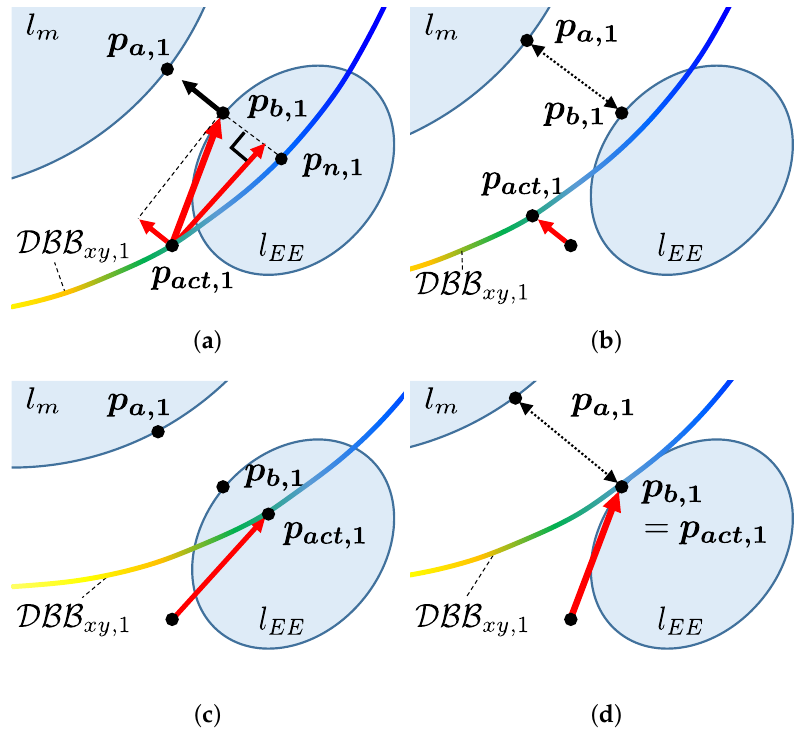
Figure 7. Illustration of the direction of force considering collision between the end-effector l EE and mobile robot l m . DBB xy ,1 denotes the points whose heights are same as that of the closest point p b ,1 on the end-effector. The points are colored by the score (yellow: high, blue: low). ( a ) The direction of the force starts from the acting point p act ,1 and points toward p b ,1 . The force can be decomposed into two orthogonal components; ( b ) one of them moves the mobile robot away from the end-effector; ( c ) the other direction places the high-score part of DBB closer to the end-effector; ( d ) by combining these components, self-collision between the end-effector and mobile robot can be